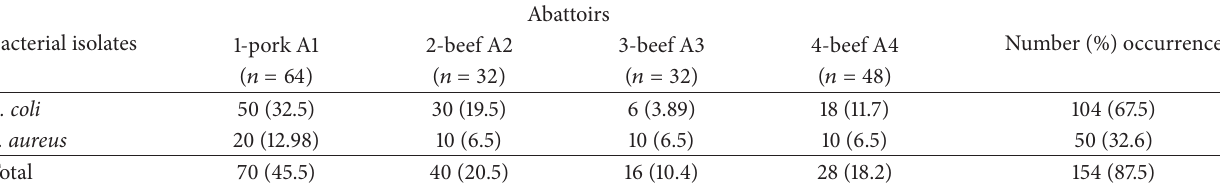
Table 3: Bacteria distribution in cattle and pig carcasses examined in the various abattoirs. Bacterial